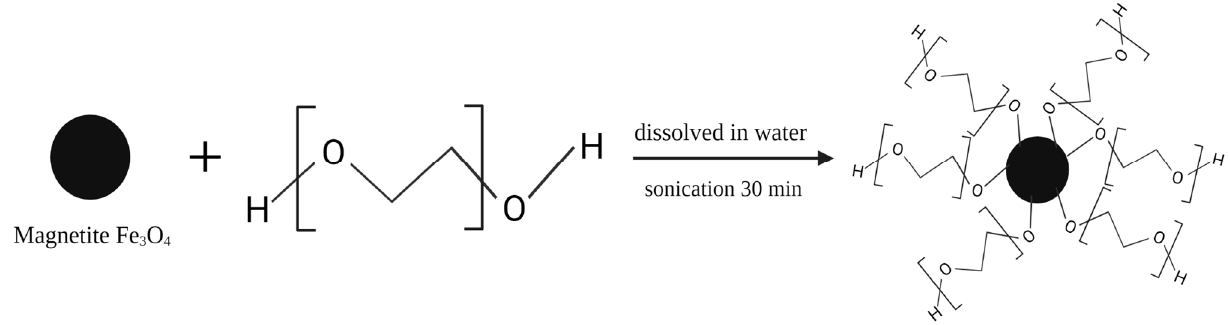
Figure 4. Surface modification using polyethylene glycol